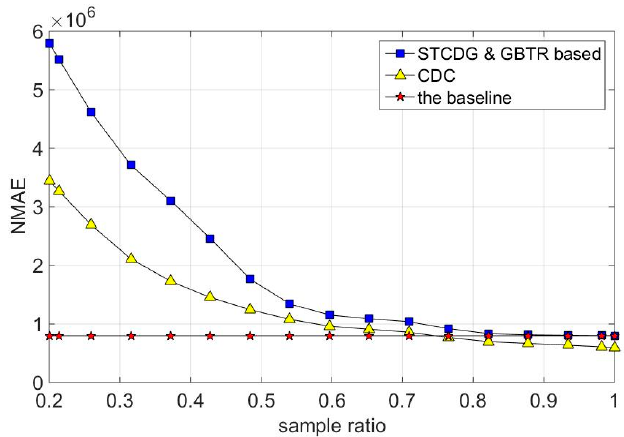
Figure 11. Network lifetime comparison.